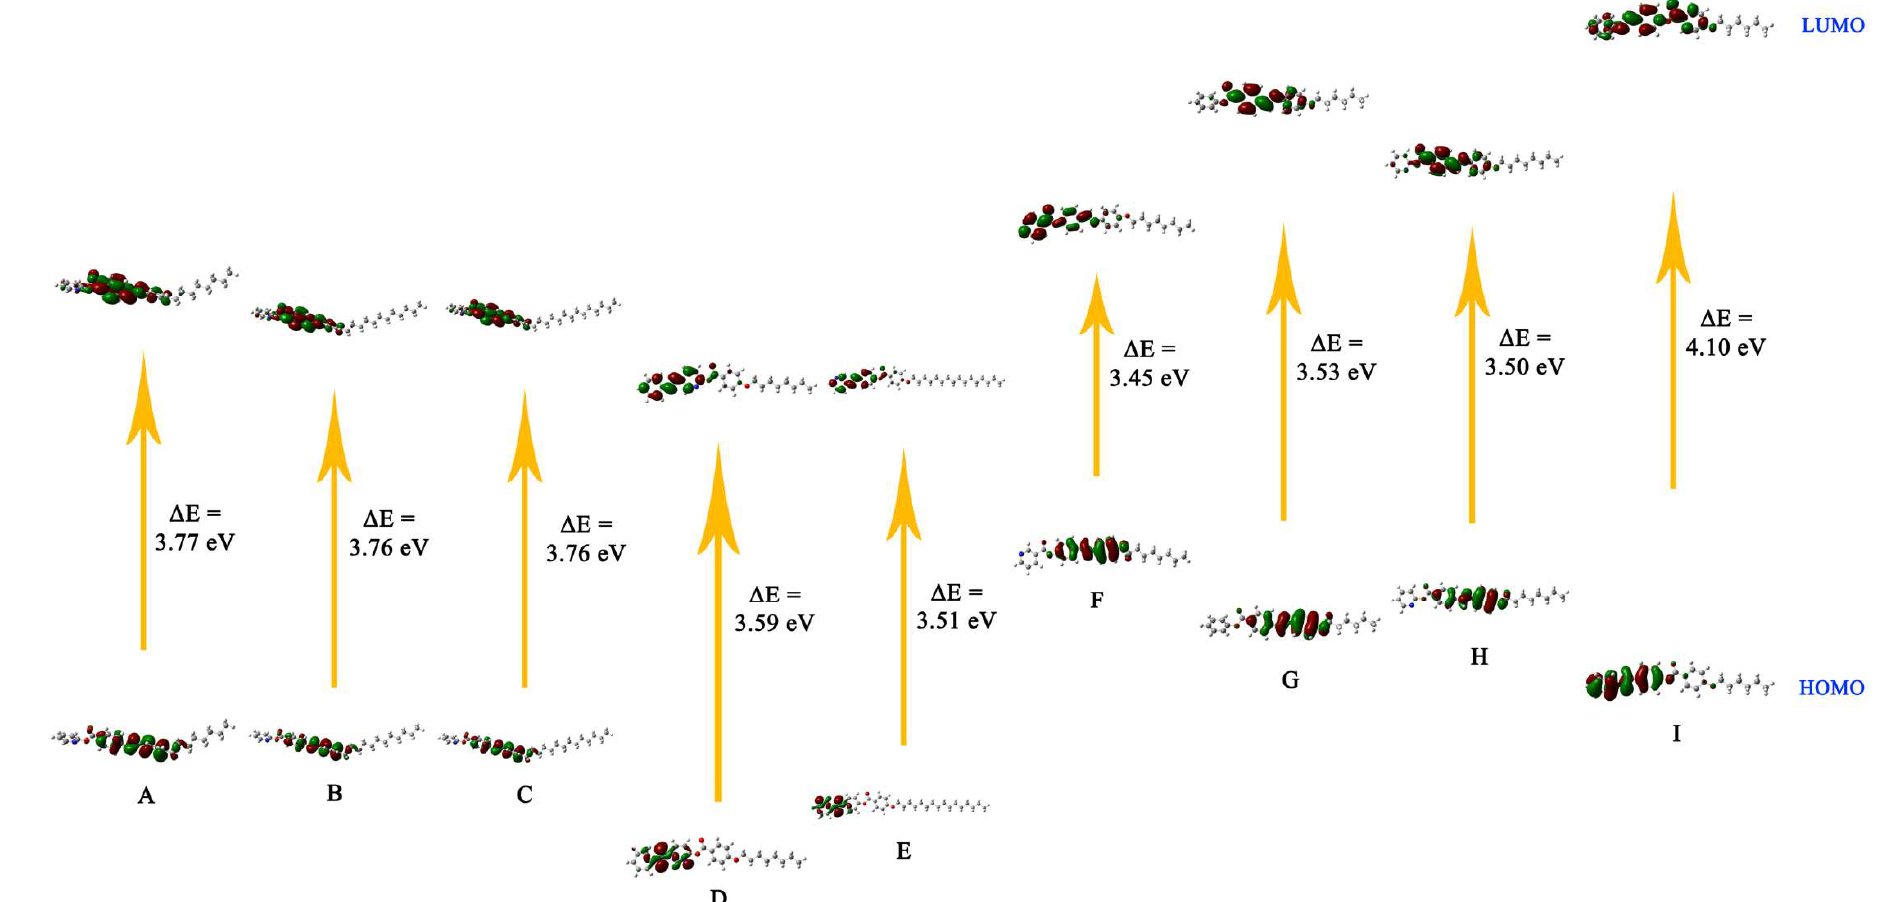
Figure 10. Graphical representation of frontier molecular orbitals and energy gaps of A , B , C , D , E , F , G , H , and I compounds.